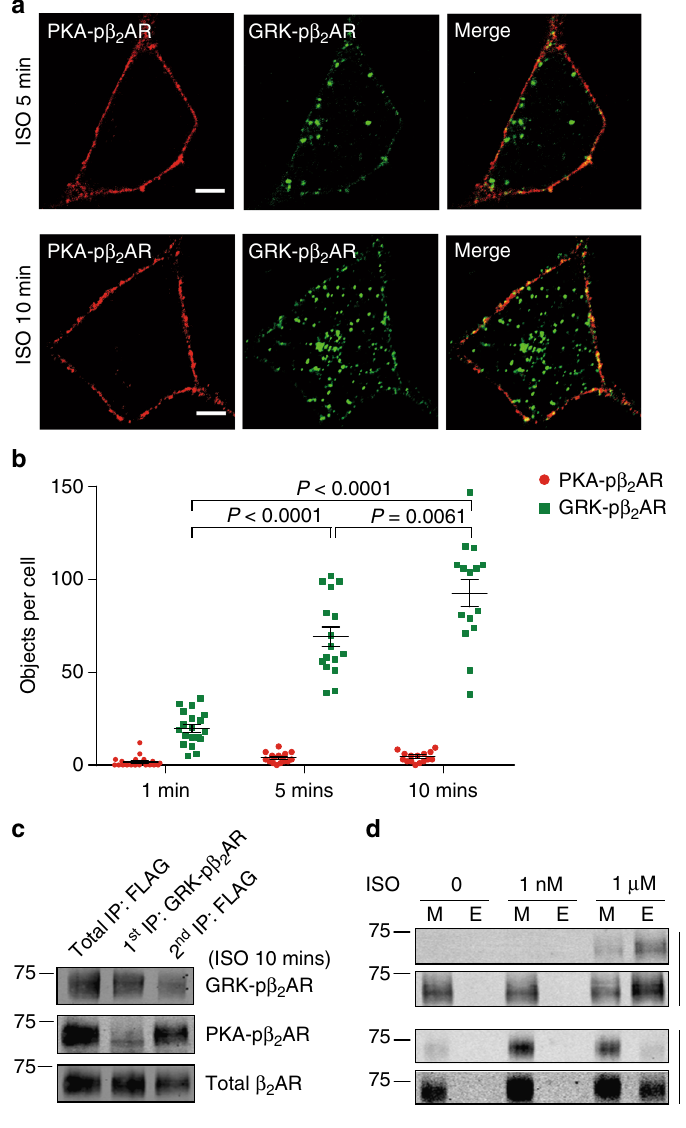
Fig. 2 PKA- and GRK-p β 2 AR undergo distinct membrane traf fi cking. a FLAG- β 2 ARs expressed in HEK293 cells were stimulated with ISO for indicated times. Confocal imaging shows PKA- and GRK-phosphorylated β 2 ARs, which were stained with anti-pS261/262 (PKA-p β 2 AR) and anti-pS355/356 (GRK-p β 2 AR) antibodies, respectively. Scale bar, 5 μ m. Representative of n = 16 and 15 cells, respectively, three independent experiments. b Numbers of fl uorescent objects in each cell in a were quanti fi ed with ImageJ ( n = 19, 16, and 15 cells, respectively, three independent experiments). Error bars denote s.e.m.; multiplicity adjusted P values are computed by one-way ANOVA followed by Tukey ’ s test between indicated groups. c Immuno-isolation of PKA- and GRK- phosphorylated β 2 ARs in HEK293 cells using same procedure as Fig. 1d after stimulation with 1 μ M ISO for 10 min. The β 2 AR in total IP and sequential IPs were resolved in SDS-PAGE, and probed with anti-FLAG, anti-pS261/262 (PKA-p β 2 AR) and anti-pS355/356 (GRK-p β 2 AR) antibodies, respectively. Representative of three independent experiments. d FLAG- β 2 ARs expressed in HEK293 cells underwent cell surface biotin labeling and then were stimulated with ISO (1 nM or 1 μ M) for 10 min. The biotin-labeled proteins on the plasma membrane were pulled with streptavidin beads, and the leftover biotin-labeled proteins in endosome were isolated by a second precipitation with streptavidin beads. Membrane (M) and endosome (E) fractions were resolved in Western blot with antibodies against FLAG, pS261/262 (PKA-p β 2 AR), and pS355/356 (GRK-p β 2 AR), showing separation of GRK- and PKA- phosphorylated subpopulations of β 2 AR. Representative of three independent experiments. Molecular weight markers (in kDa) are indicated on the